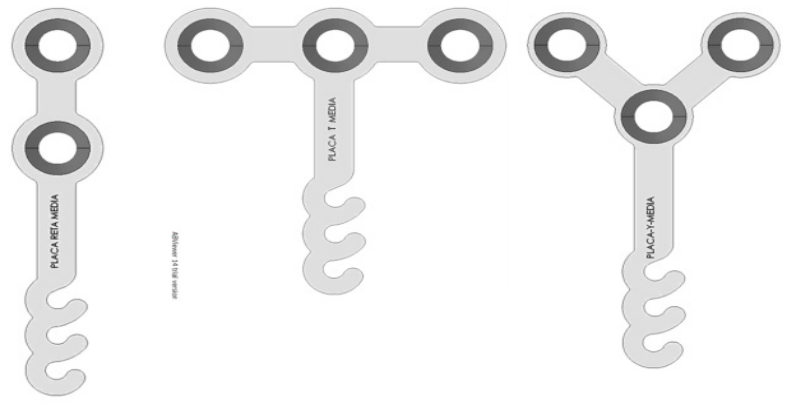
Figure 1. I-, T-, and Y-shaped miniplates. The 3D finite element model was created with the Rhinoceros 4.0 software (SR